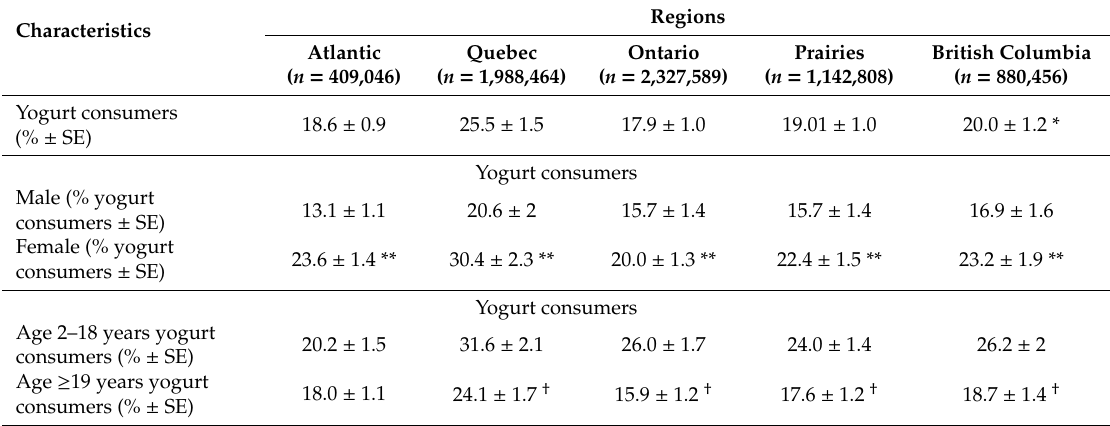
Table 2. Distribution of yogurt consumers by Canadian regions, age and sex groups 1